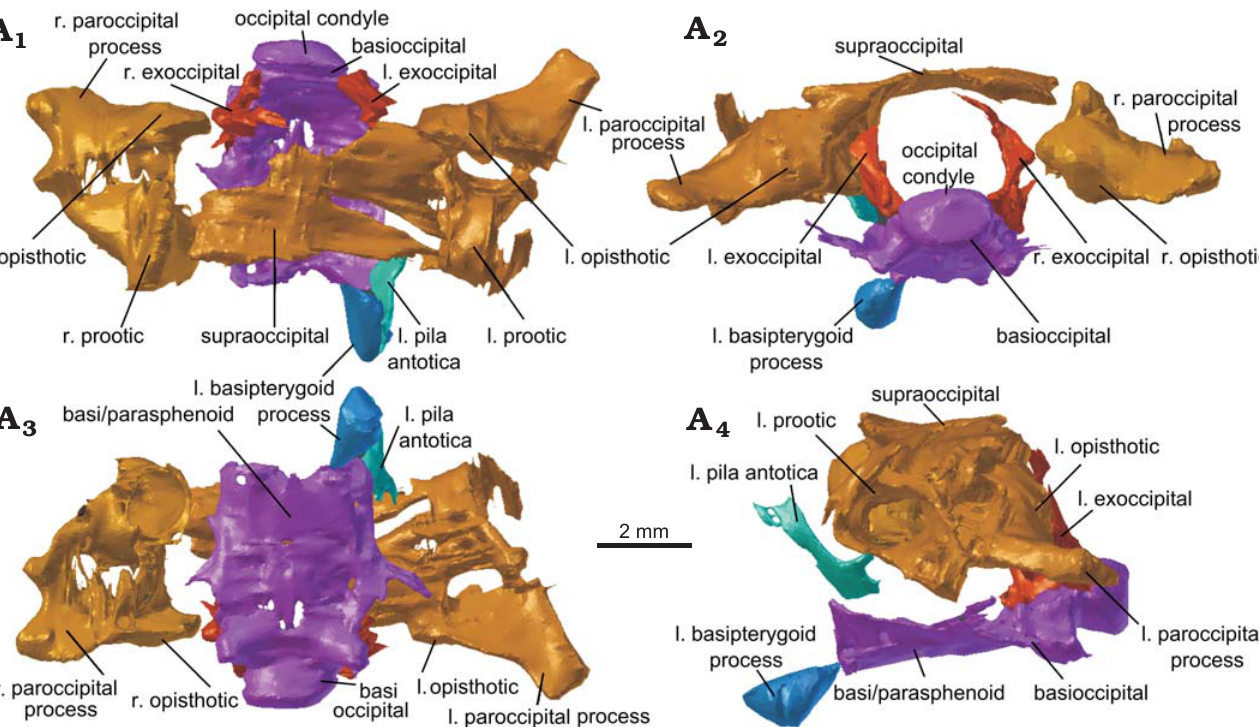
Fig. 9. The reassembled braincase of lepidosaur rynchocephalian Clevosaurus cambrica Keeble, Whiteside, and Benton, 2018 (NHMUK PV R37014) from Late Triassic, Pant-y-ffynnon, Wales, UK. In dorsal (A 1 ), posterior (A 2 ), ventral (A 3 ), and lateral (A 4 ) views. Abbreviations: l., left; r.,